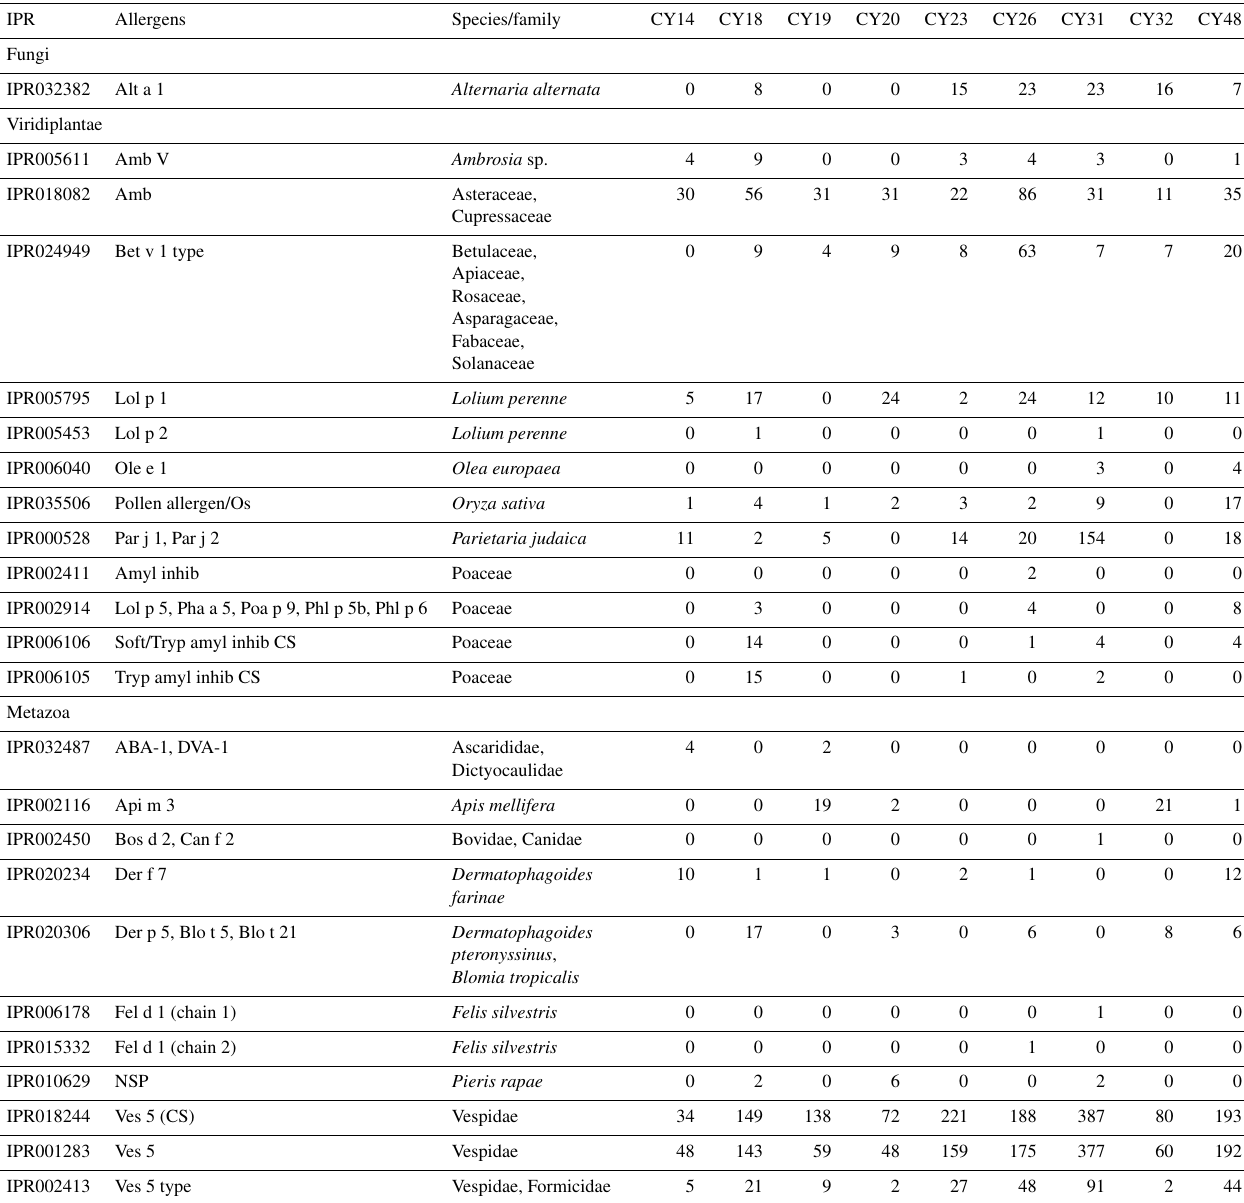
Table C1. Protein-encoding reads for allergens. Overview of InterPro matches and read counts for allergenic protein-encoding reads. IPR indicates the InterPro accession